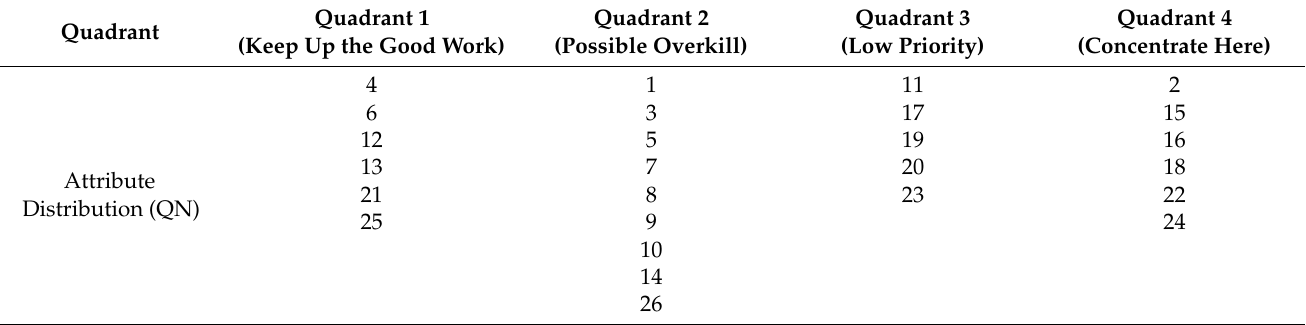
Table 7. Distribution of 26 attributes in revised